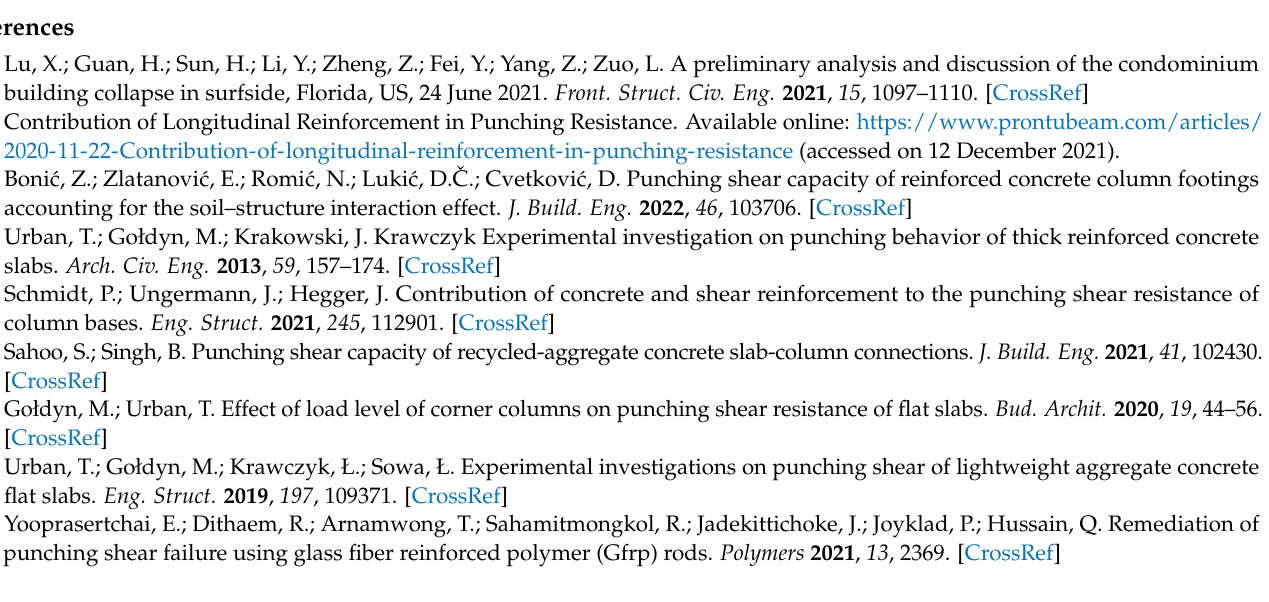
Figure A5. Graphs of the shear forces in the control perimeter depending on the shear cap height—240 cm shear cap width (c/d =